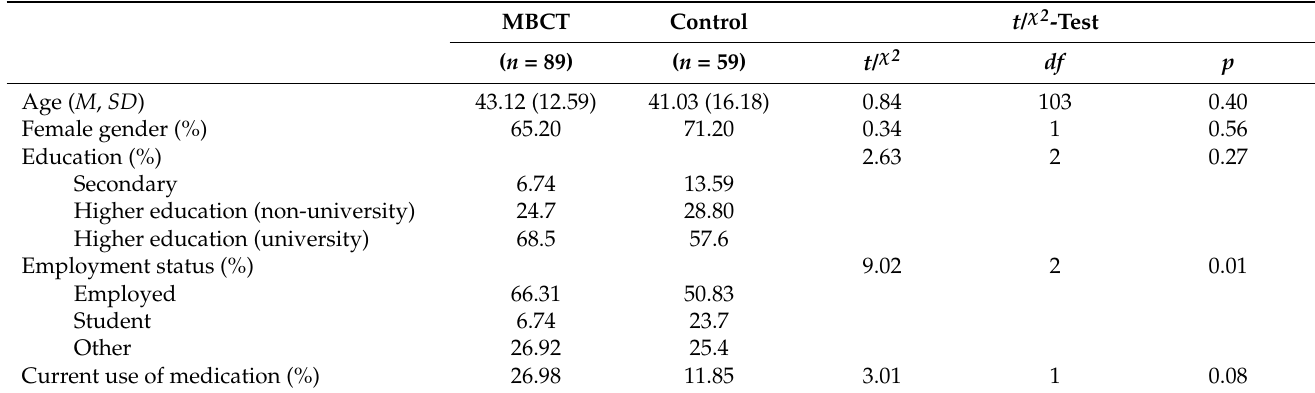
Table 1. Baseline demographic and clinical characteristics per